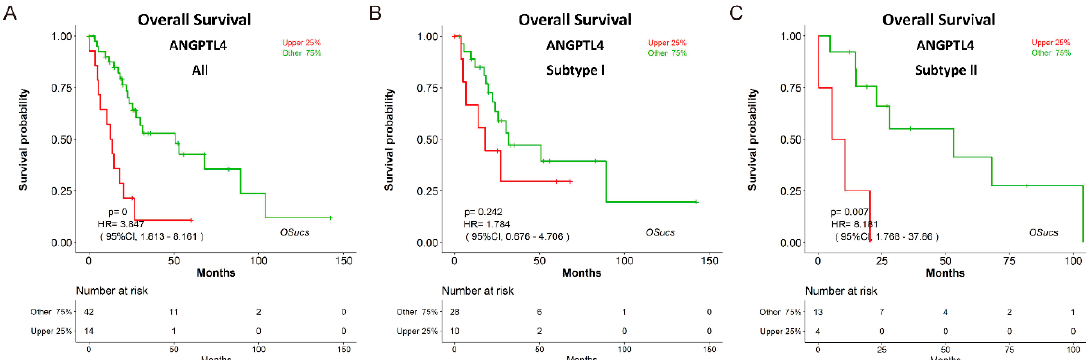
Figure 5. Evaluation of the prognostic value of angiopoietin-like protein (ANGPTL4) in OSucs. Kaplan-Meier plots for ANGPTL4 in ( A ) All, ( B ) Subtype I, and ( C ) Subtype II UCS, respectively. p = 0 denotes p < 0.001.